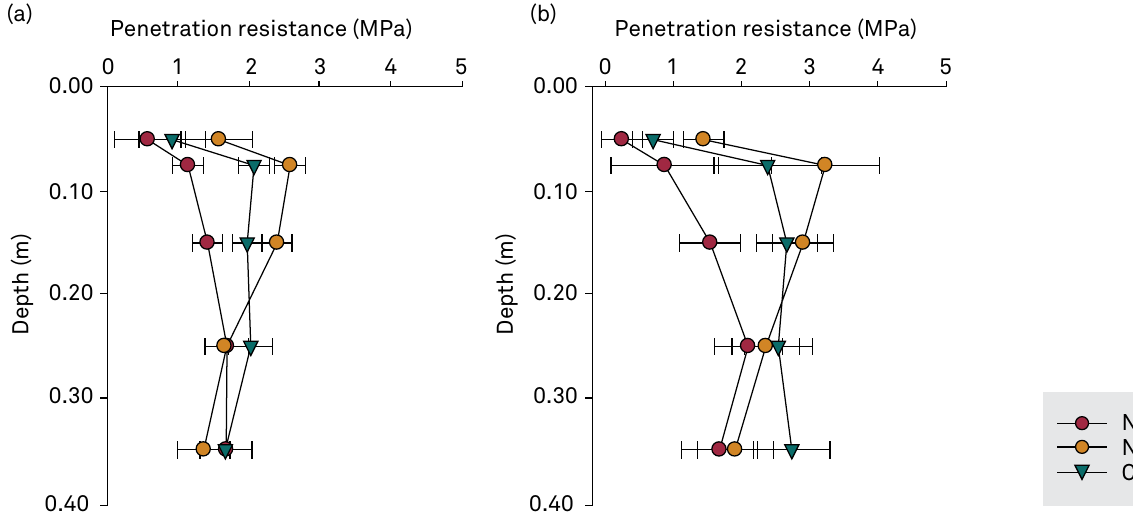
Native Forest NTwl